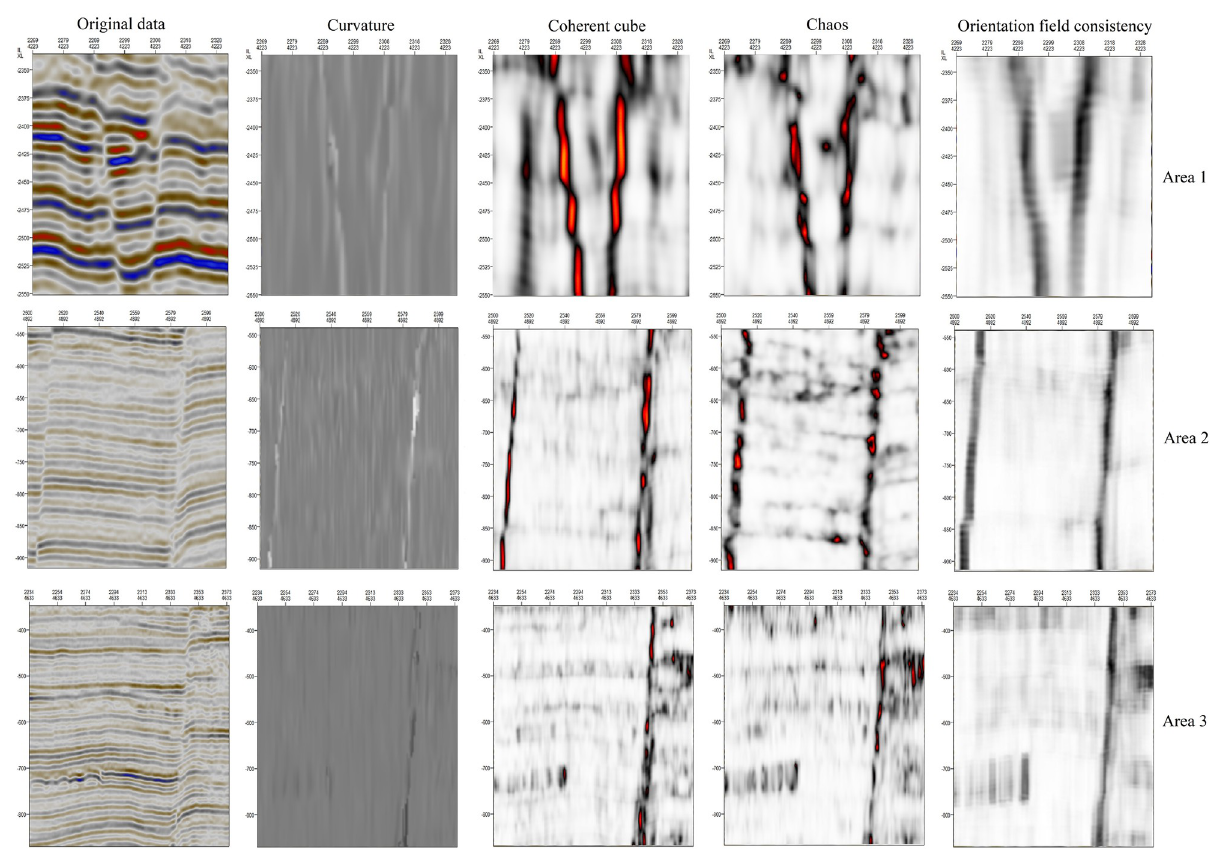
Fig 13. Comparison of different fault enhancement methods.